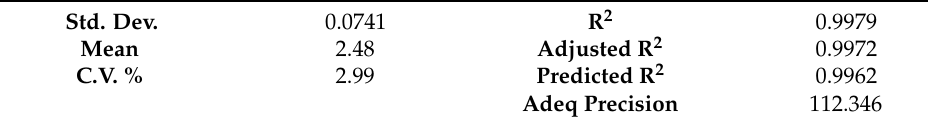
Table 3. Fit statistics of support volume.